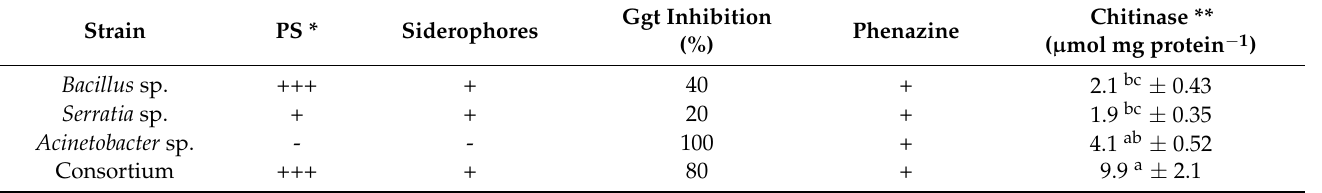
Chitinase ** Ggt Inhibition Phenazine ( µ mol mg protein − 1 ) (%)